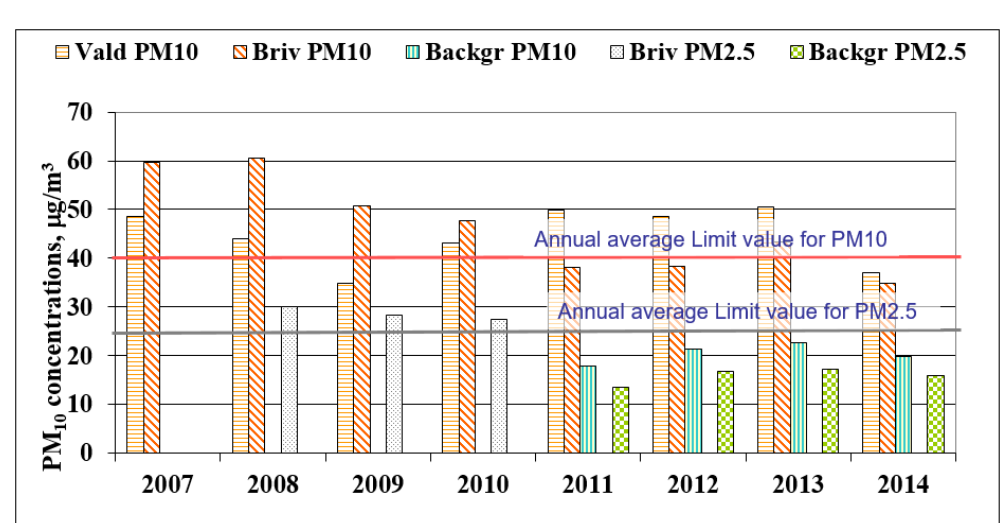
Fig. 2. PM annual concentration changes at street and urban background level in Riga, 2007 ‒ 2014.